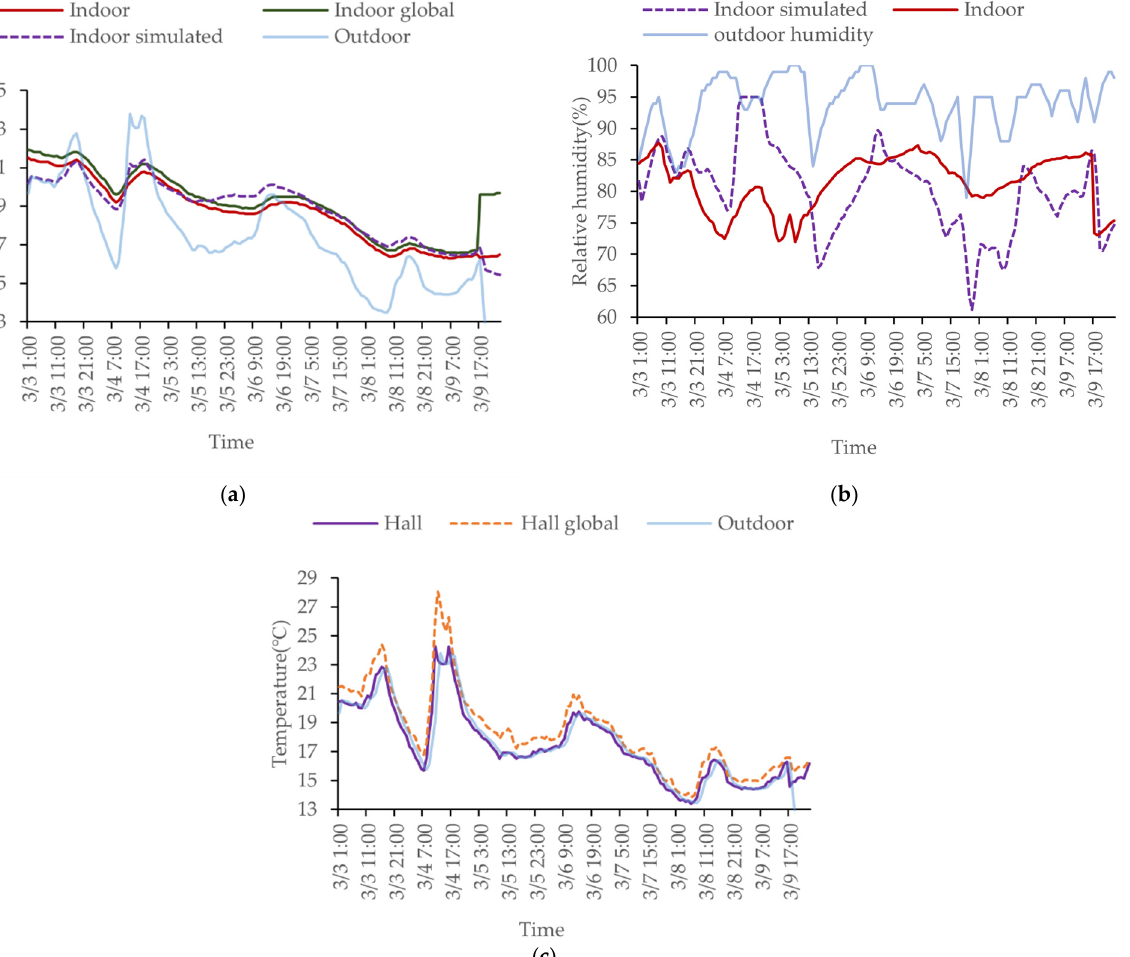
Figure 5. Comparison of measured and simulated values in winter: ( a ) Indoor temperature; ( b ) Indoor relative humidity; ( c ) hall temperature.